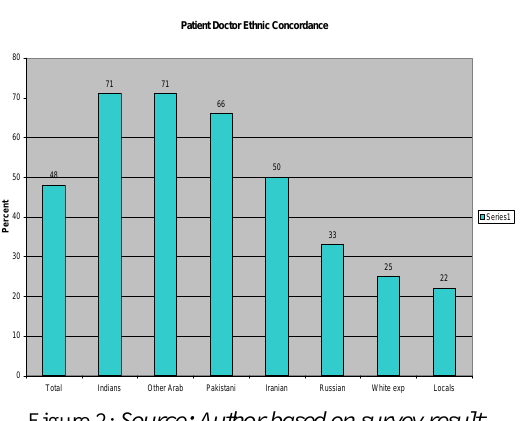
Figure 2: Source: Author based on survey result Overall, 48 percent of the respondents went to doctors with the same nationality as themselves.